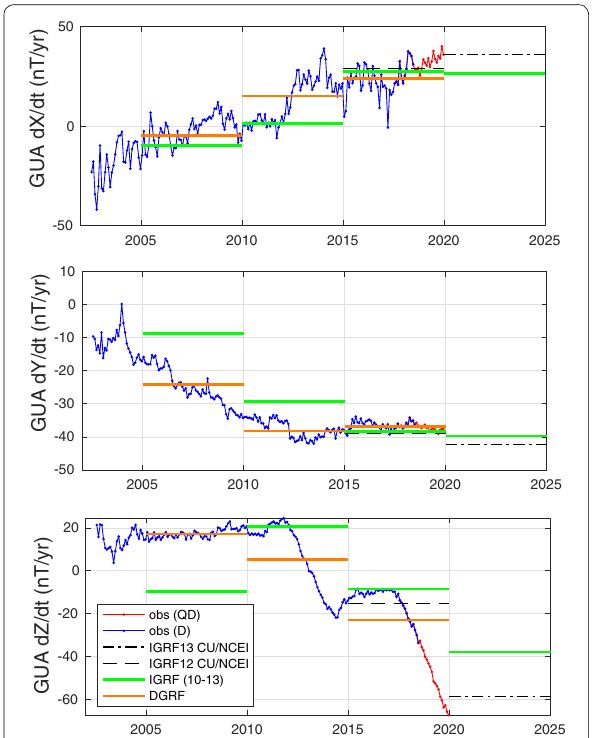
Fig. 4 Secular variation at Guam observatory (GUA, 13.59 ◦ latitude, 144.87 ◦ longitude). Observatory annual differences from definitive (D) and quasi-definitive (QD) data. Model predictions from CU/NCEI SV candidate models to IGRF13 and IGRF12. Model predictions from IGRF10, IGRF11, IGRF12, IGRF13 SV models, and from the most recent DGRF (IGRF13)